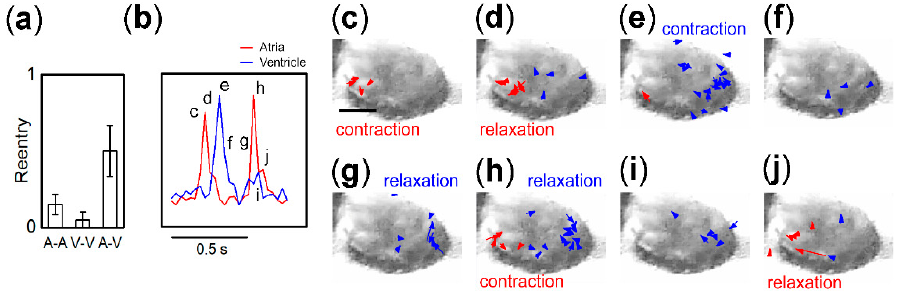
Figure 5. ( a ) Fraction of fragment pairs exhibiting reentry-like beat pulse sequences. ( b ) Example of irregular pulse sequence of A-V pair. ( c – j ) Original images of ( b ) with motion indicated by arrows. Contraction ( c ) and relaxation ( d ) occurring in the left fragment, which entrains as a contraction of the right fragment ( e ). While the right fragment shows relaxation from ( g ) to ( h ), the left fragment displays contraction ( h ) followed by relaxation ( j ). Scale bar in ( c ) is 0.3 mm.